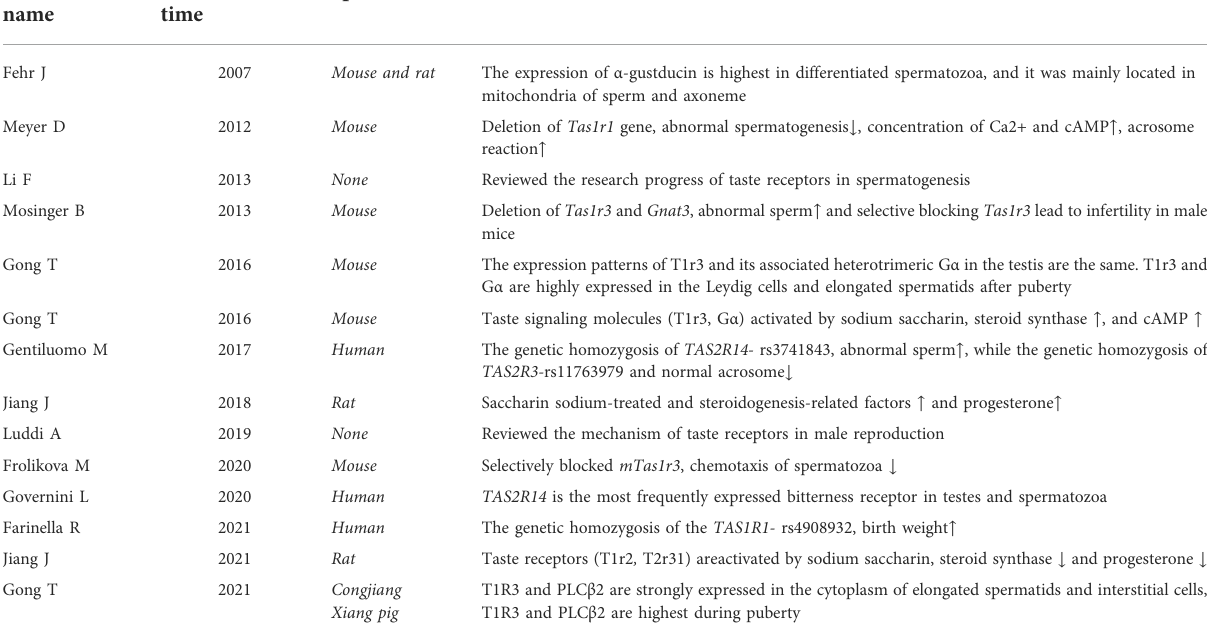
TABLE 1 Related literature on the effect of taste receptors in male